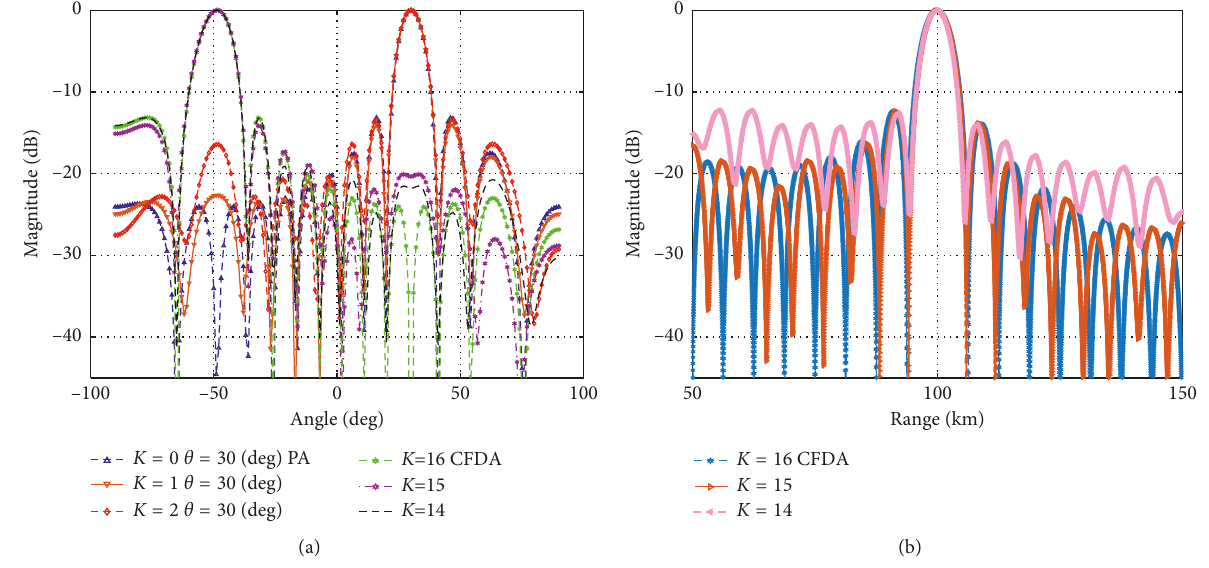
Figure 5: Target responses when θ � 30 ° , t � 4/ Δ f for (a) the angle profile when R